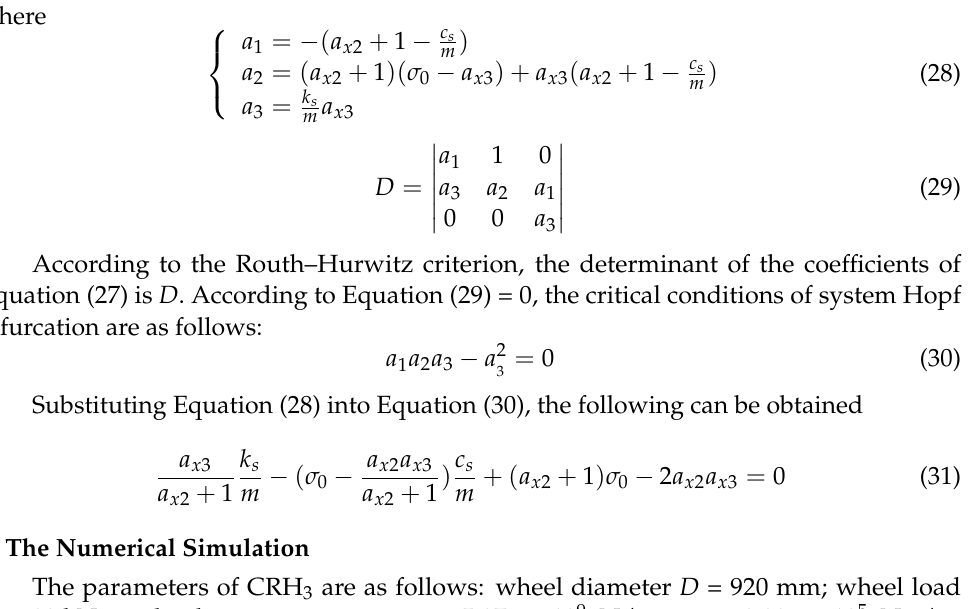
( b ) Figure 4. Critical curve between parameters β and P 0 , ξ : ( a ) P 0 – β critical curve; ( b ) ξ – β critical curve. The alterations in the ξ – β critical curve are comparable to those in the P 0 – β critical curve. The instability zone shrinks fast as ξ increases. The vibration equation is solved and the impact of each parameter is explored to validate this result and determine the chang- ing characteristics at the critical point. 4.3. Influence of Parameters on Self-Excited Vibration Characteristics 4.3.1. Speed Taking the speed ratio β = 0.1~2.0 to investigate the vibration characteristics at various rotating speeds, the bifurcation diagram in Figure 5 shows that, when the speed is low, the wheel cannot create self-excited vibration. When β = 0.2, the stable equilibrium point loses stability, and Hopf bifurcation leads to periodic oscillation, i.e., the wheel generates self-excited vibration. The system becomes stable again at β = 1.8 and is increased further.